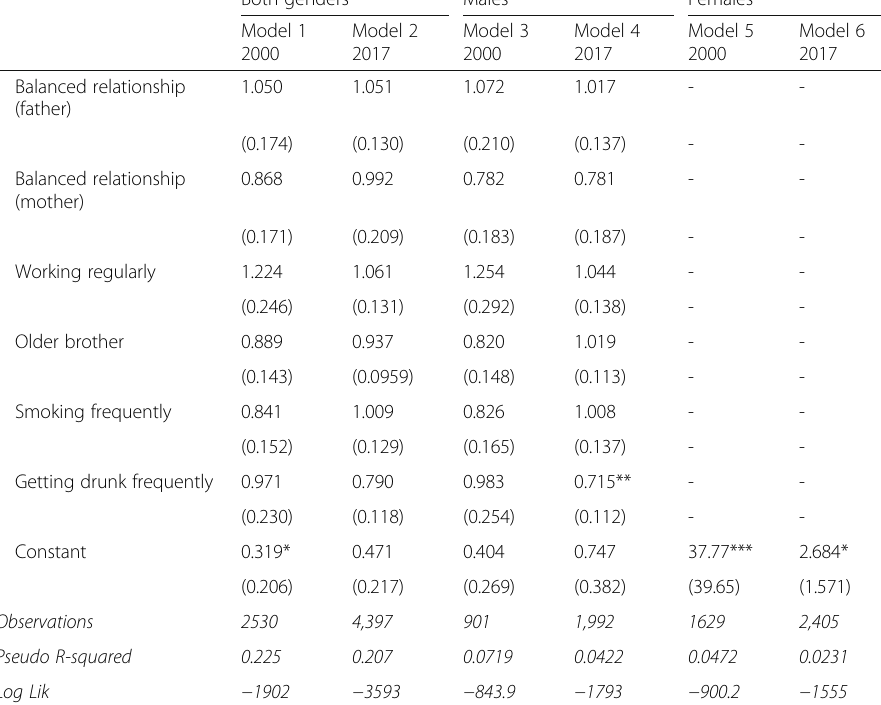
Table 7 Results of multinomial (for both genders and men) and binary (for women) logistic regression models (relative risks and odd ratios) of partners ’ age differences at first sex on key determinants and control variables for 2000 and 2017 SELFY waves